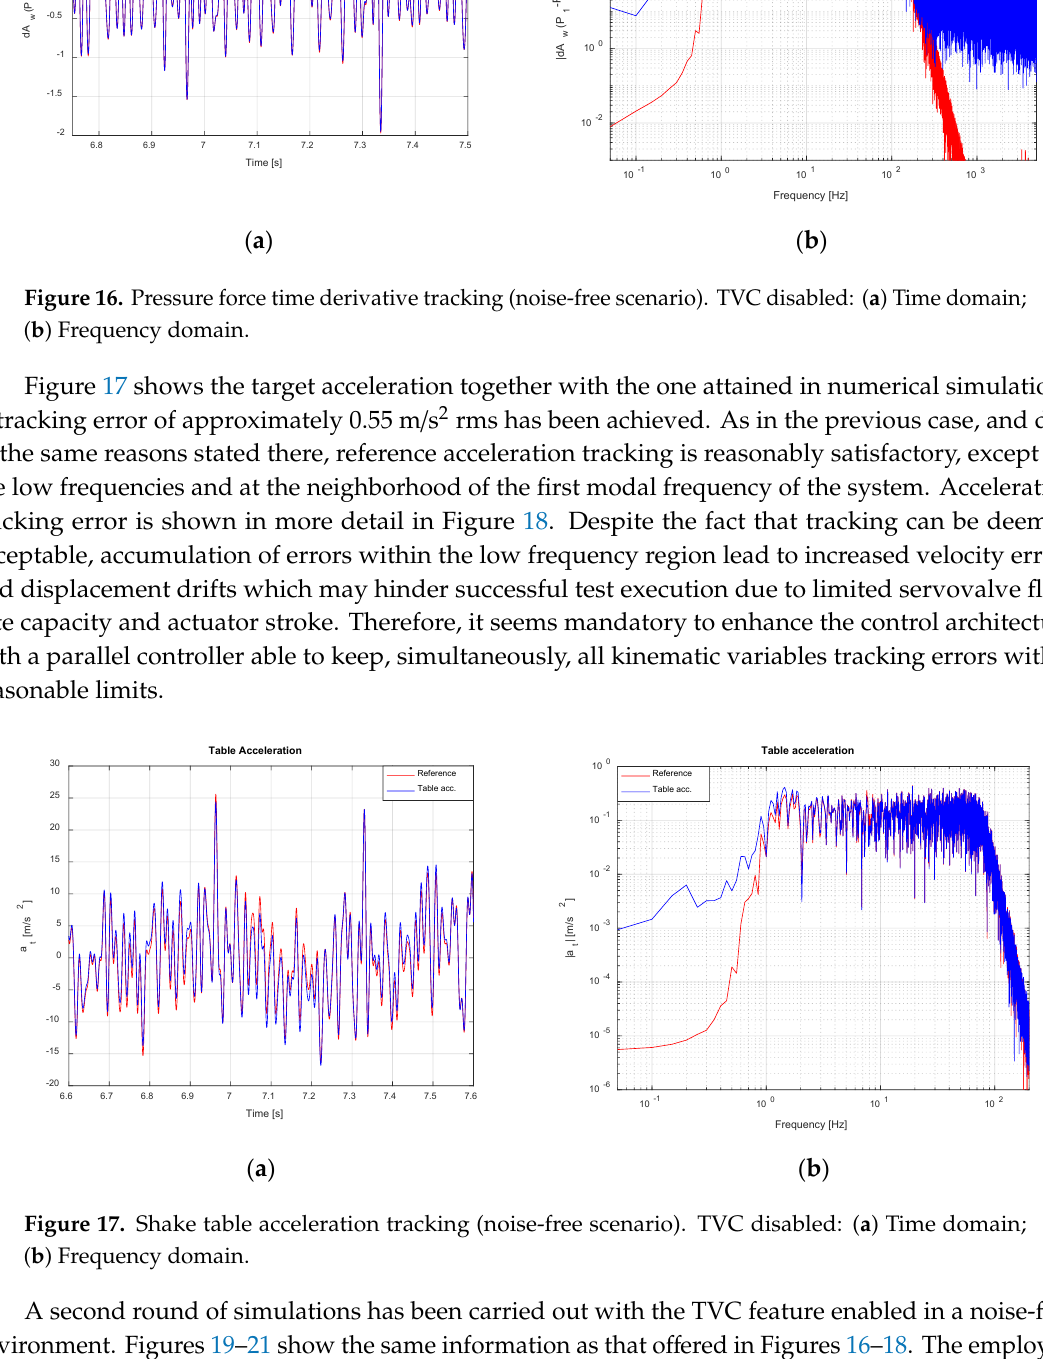
Figure 15. Spool position tracking (noise-free scenario). TVC disabled: ( a ) Time domain; ( b ) Frequency domain.